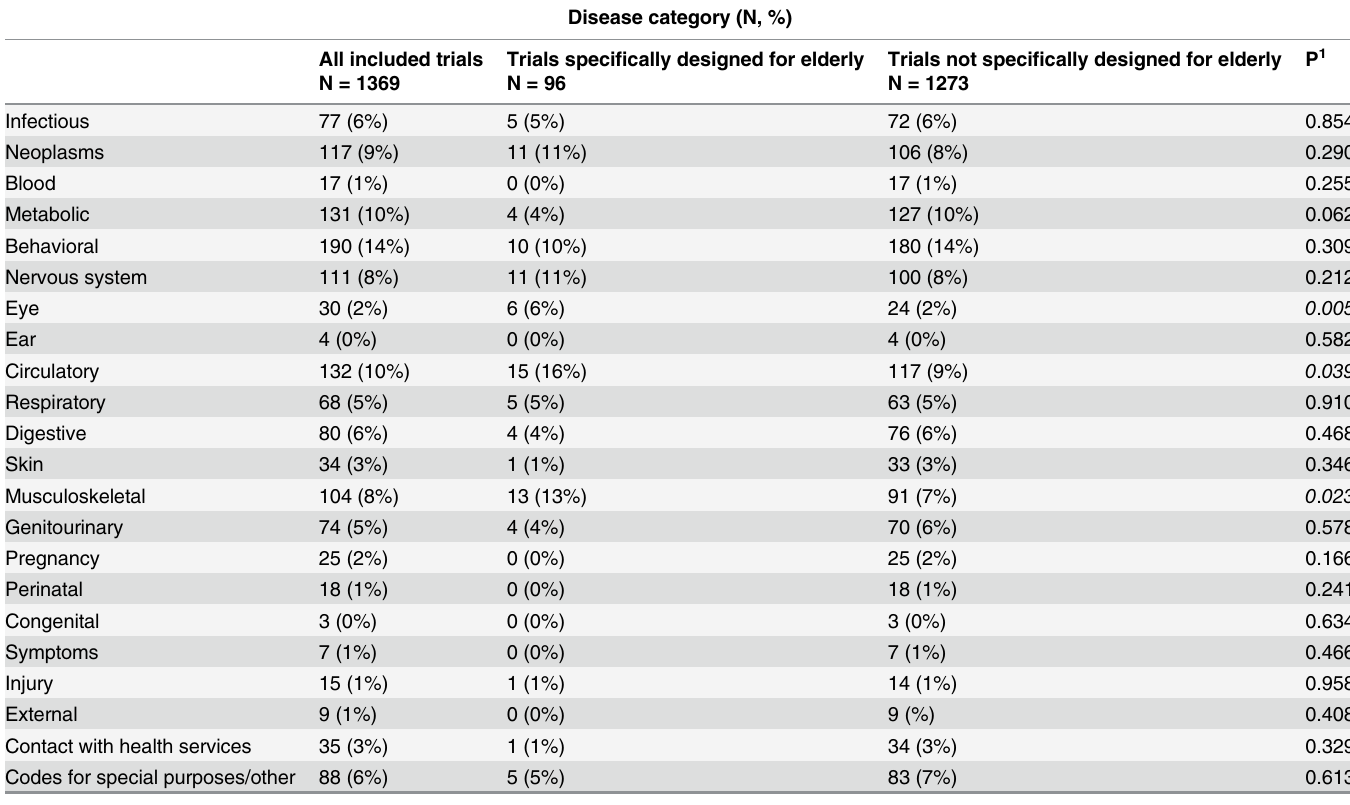
Table 2. Disease categories of 1369 included